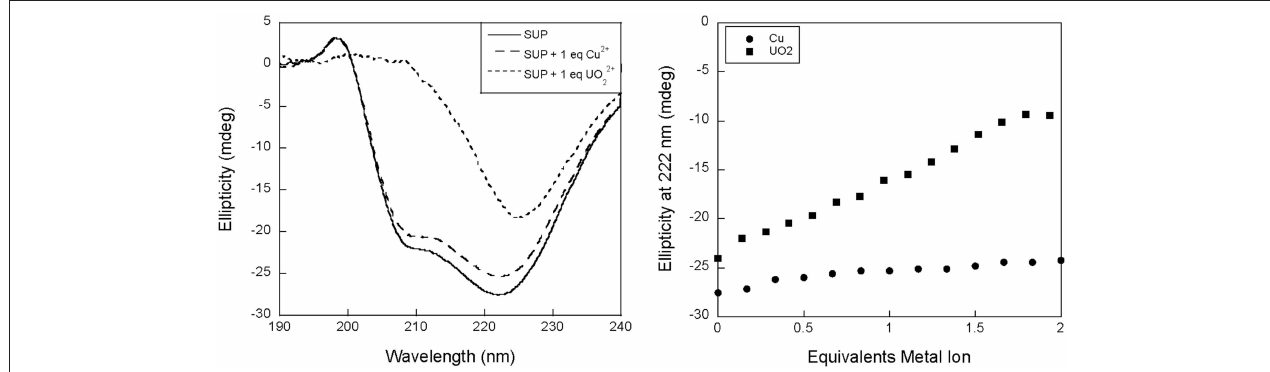
FIGURE 2 | Changes to the circular dichroism spectrum of SUP in the presence of Cu 2 + and UO 2 + 2 . (Left) CD spectra of SUP in absence and presence of metal ions. (Right) corresponding titration curves.